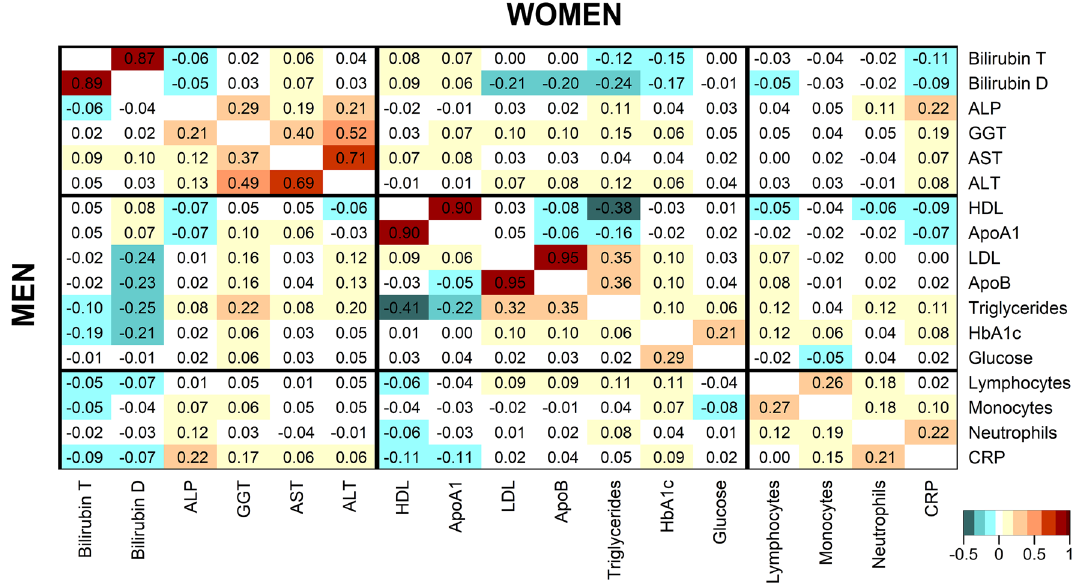
Figure 5. Correlations between biomarkers, independent of body size and body shape. ABSI – a body shape index; ALP – alkaline phosphatase; ALT – alanine aminotransferase; ApoA1 – apolipoprotein A1; ApoB – apolipoprotein B; AST – aspartate aminotransferase; Bilirubin D – direct bilirubin; Bilirubin T – total bilirubin; BMI – body mass index; CRP – C-reactive protein; GGT – gamma-glutamyltransferase; HbA1c – haemoglobin A1c (glycated haemoglobin); HDL-C – high-density lipoprotein cholesterol; HI – hip index; LDL-C – low- density lipoprotein cholesterol; Ly – lymphocytes; Mo – monocytes; Neu – neutrophils. Values represent partial Pearson correlation coefficients (men – bottom-left; women – top-right) with adjustment for BMI, ABSI, HI, height, age at enrolment, Townsend deprivation index, time of blood collection, fasting time (continuous), weight change within the last year preceding enrolment, smoking status, alcohol consumption, physical activity, use of nonsteroidal anti-inflammatory drugs, paracetamol use, and in women, menopausal status, hormone replacement therapy use, and oral contraceptives